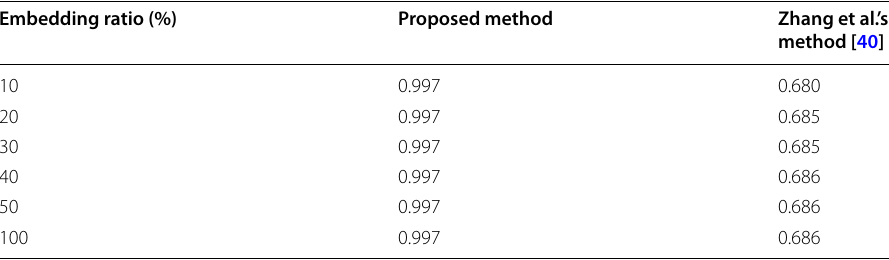
Table 8 Comparison of the precision of methods for the BOWS2 database image Embedding ratio